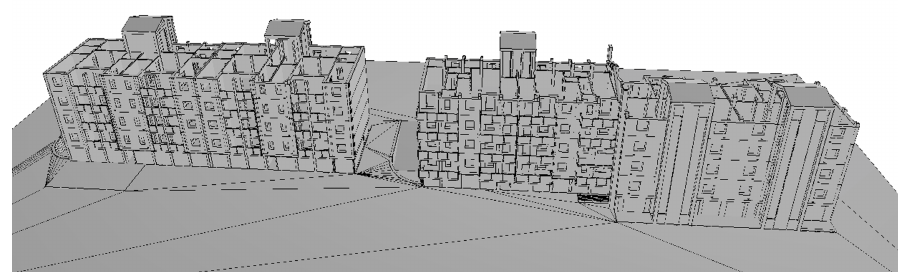
Figure 4. Example of Savigliano model converted to CityGML. Each object is converted to GenericCityObject , with lod4Geometry